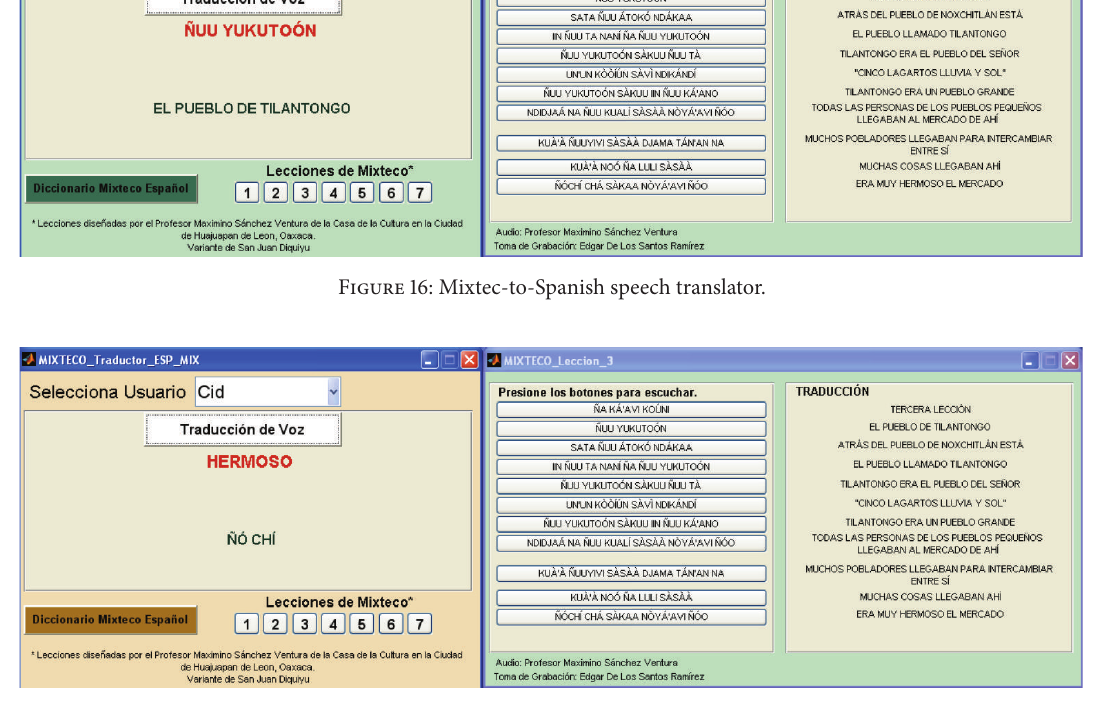
Figure 17: Spanish-to-Mixtec speech